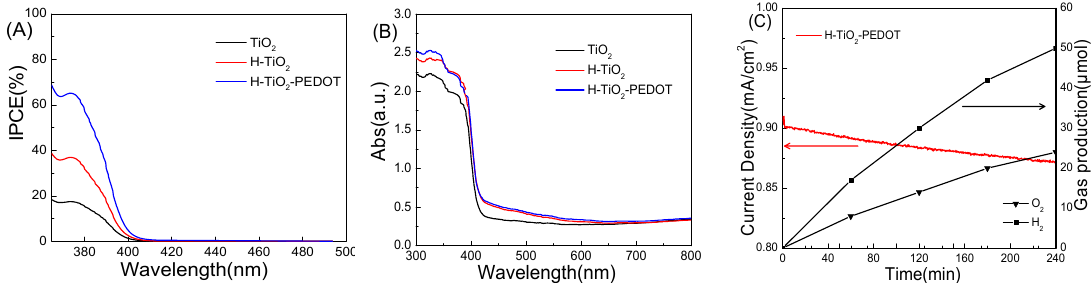
Figure 6. The IPCE curves of series photoelectrodes under 0.5 V (vs. Ag / AgCl) ( A ), UV-Vis DRS of series photoelectrodes ( B ), the stability test of H-TiO 2 -PEDOT under 0.5 V (vs. Ag / AgCl) and corresponding oxygen and hydrogen evolution performance ( C ).